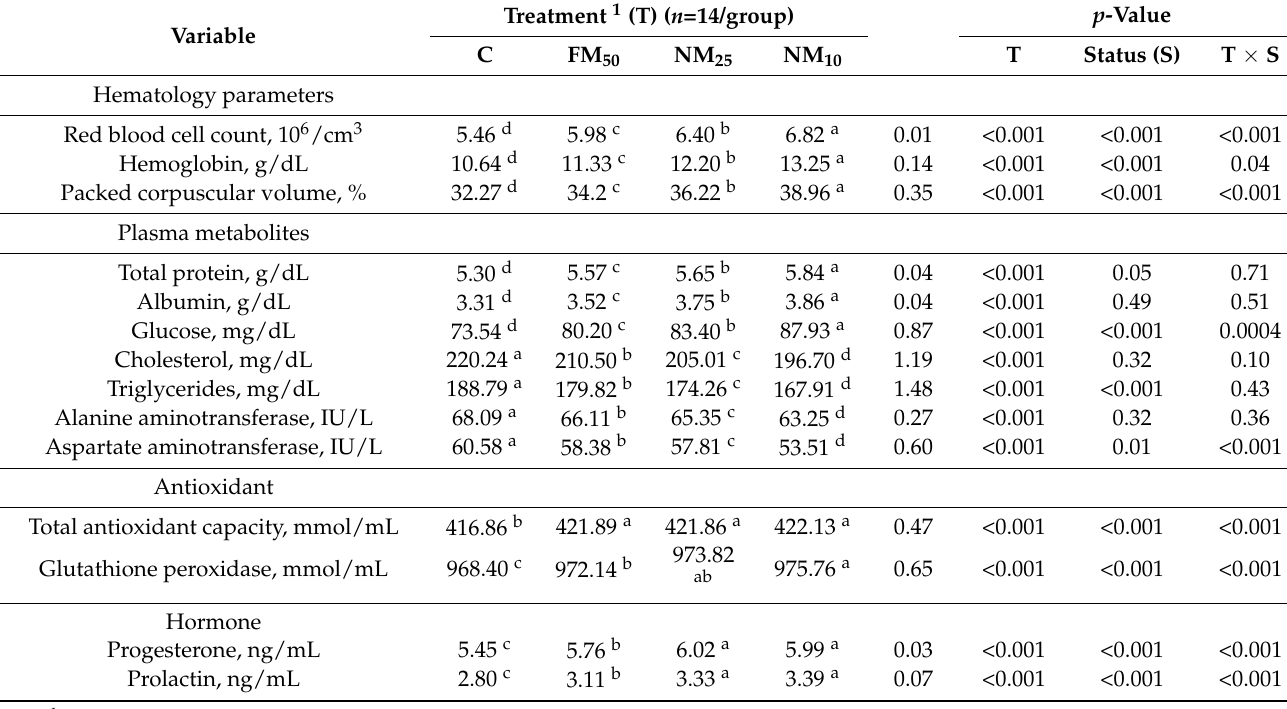
Table 6. Effect of nanoencapsulated Moringa leaf ethanolic extract (MLEE) on the blood plasma of female rabbits during the experimental period (mean ± SEM).